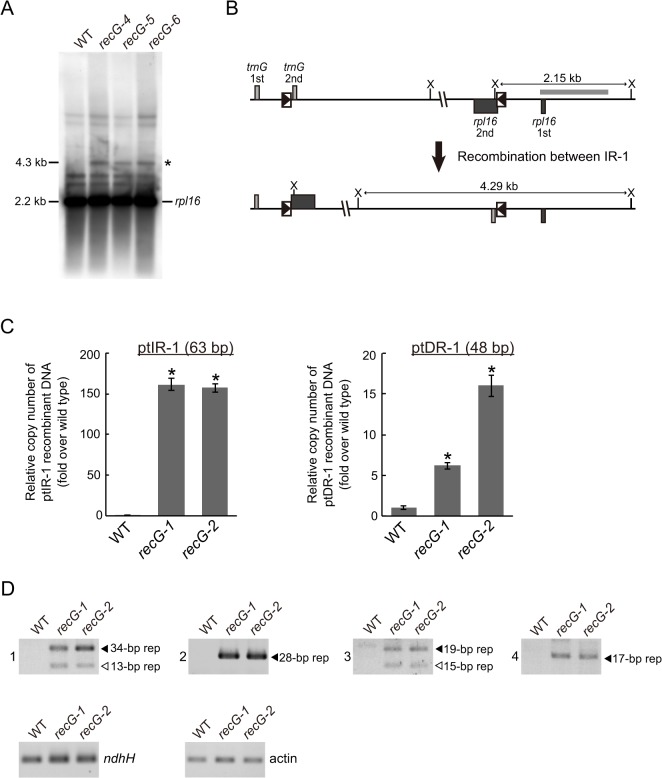
Genomic instability in RECG KO plastids.
A. ptDNA configuration at the ptIR-1 (rpl16) locus. DNA from WT and RECG KO strains digested with XhoI were probed with rpl16 probe. The asterisk denotes signals corresponding to DNA recombined between ptIR-1 repeats. The length of the bands is indicated on the left. B. Schematic explanation of the DNA structures detected in (A). Intramolecular recombination between ptIR-1 causes inversion of a segment between ptIR-1. The XhoI recognition sites are indicated by X. The boxes represent exons, and the lines between boxes represent introns or noncoding flanking sequences. ptIR-1 are indicated by black triangles in the boxes. The positions of the probes used in (A) are indicated by thick gray line. C. The amount of DNA generated by recombination between ptIR-1 (63 bp) or ptDR-1 (48 bp). Relative copy number of DNA per plastid ndhH DNA was measured by qPCR. WT was given a value of 1. The data represent mean of three replicates ± SD. *p<0.01 (versus WT). D. DNA generated by recombination between short (<35 bp) repeats. PCR reaction numbers indicated on the left of the pictures correspond to those in S3 Table. Plastid gene ndhH and nuclear gene actin were amplified as a control. Filled and blank triangles indicate DNA with the expected and unexpected sizes, respectively.